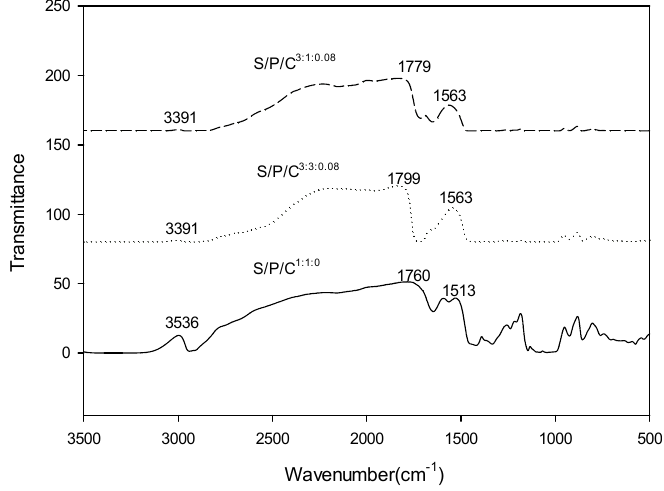
Figure 2. FTIR spectra of starch/polyvinyl alcohol/citric acid ternary blend functional food packaging films.